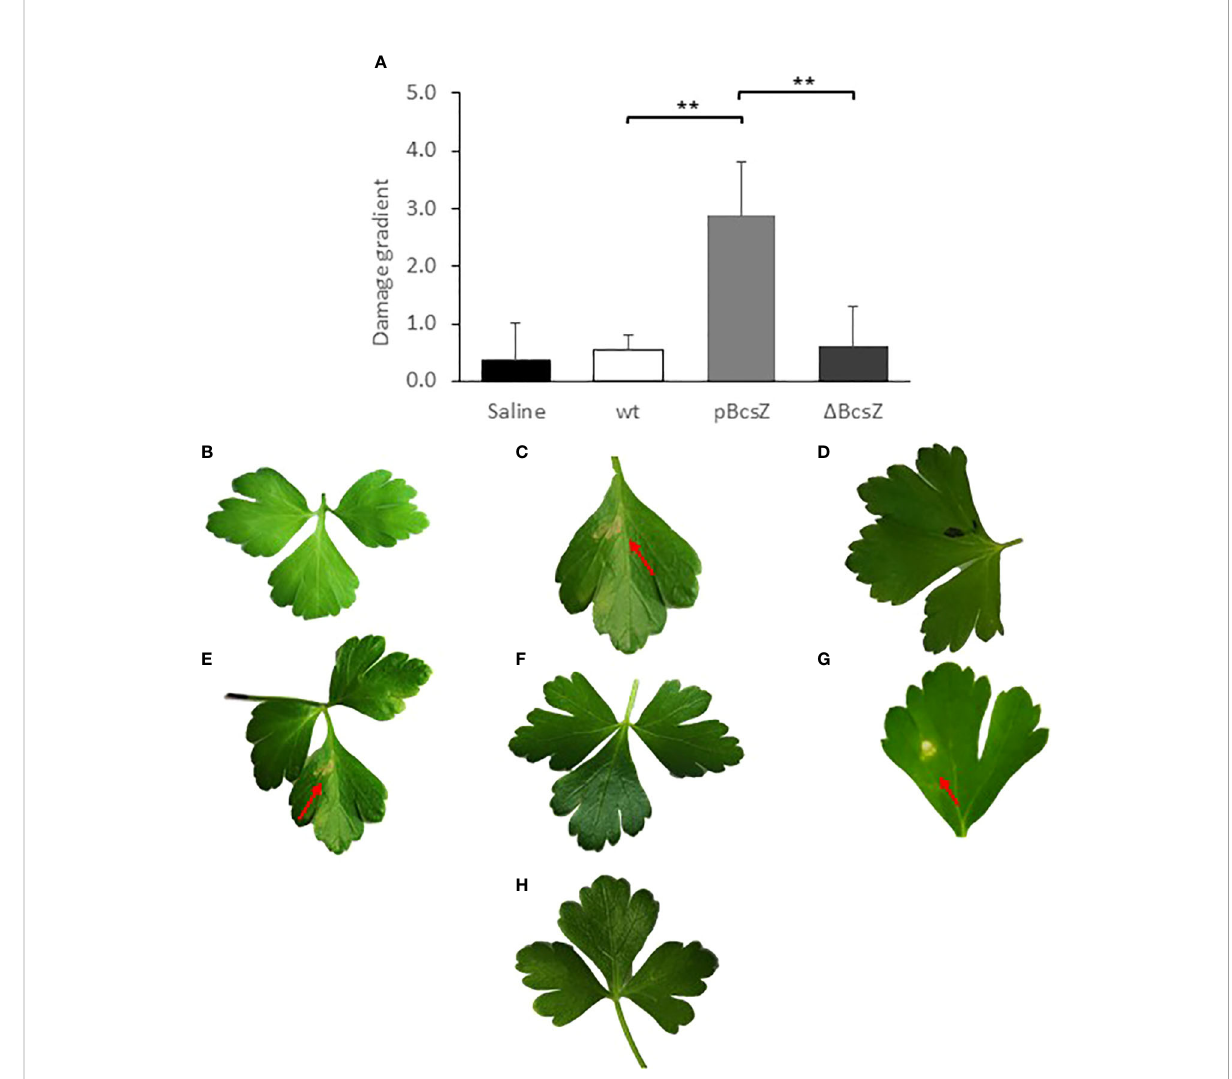
FIGURE 5 Necrotic damage on parsley leaves in fi ltrated with different Salmonella strains and solutions. (A) Summary of the necrotic damage intensity 7 days post in fi ltration. The damage in each leaf was scored according to a damage gradient described in Figure S2, and the mean scores of all leaves were calculated. The experiment was conducted in 3 repeats and statistical calculations were performed using Kruskal-Wallis test. ** P < 0.001. Error bars represent standard deviations. B-H. Images of representative leaves. (B) Parsley leaves 7 days after bacterial in fi ltration of w.t., no leaf damage was observed. (C) Parsley leaves 7 days after pBcsZ in fi ltration, necrotic damage on leaves was observed. (D) Parsley leaves 7 days after bacterial in fi ltration of D BcsZ, no damage was observed. (E) Parsley leaves in fi ltrated with the puri fi ed r-BcsZ, necrotic leaf damage was observed. (F) Parsley leaves In fi ltrated with buffer solution as control. (G) Parsley leaves in fi ltrated with degradation products of BcsZ, necrotic leaf damage was observed. (H) In fi ltration of the denaturized enzyme r-BcsZ, no damage was observed. Red arrows point to the necrotic spots formed in the parsley